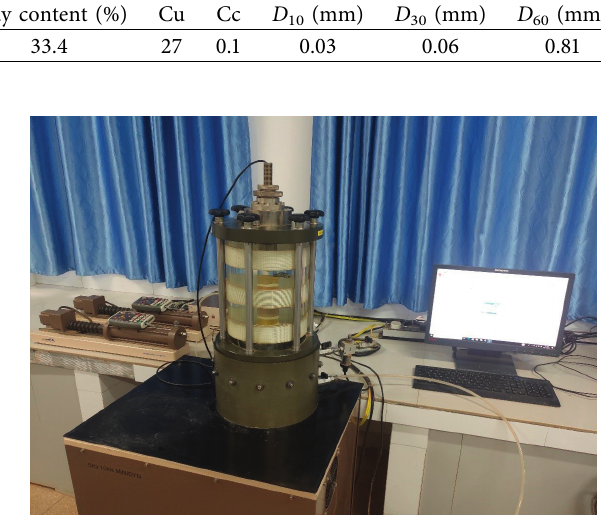
Figure 4: GDS cyclic triaxial testing